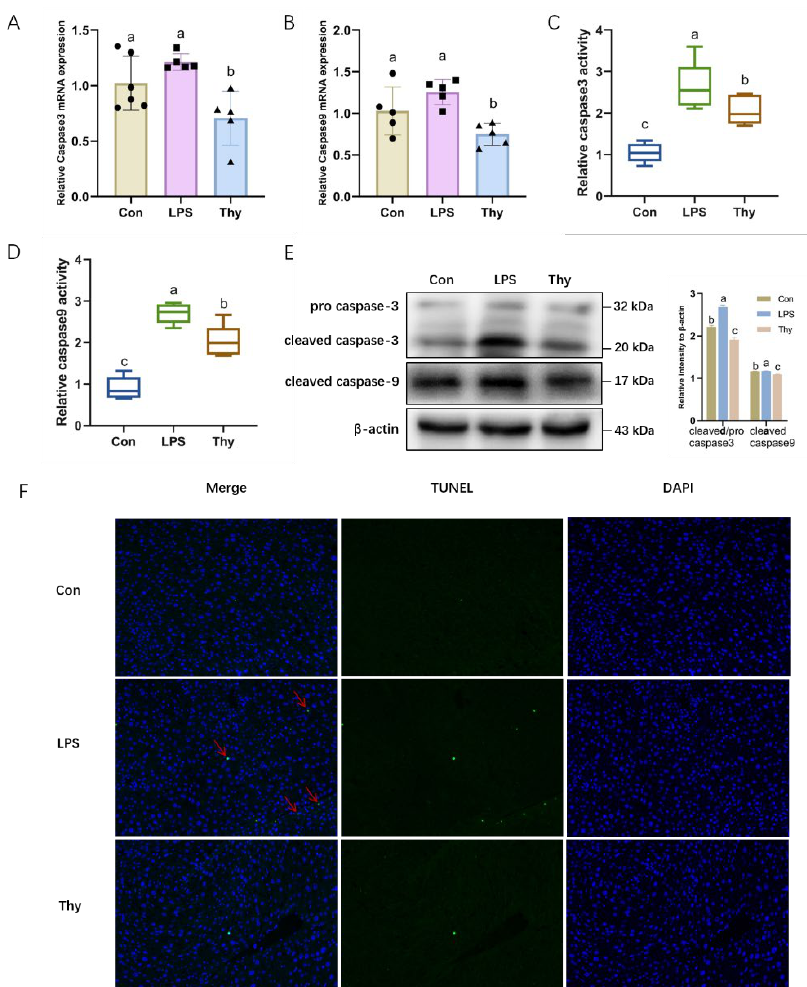
Figure 4. Thymol ameliorates LPS-induced apoptosis. The mRNA levels of apoptosis-related genes ( A ) caspase3 and ( B ) caspase9 in liver ( n = 5–6). The activity of ( C ) caspase3 and ( D ) caspase9 in liver ( n = 5–6); ( E ) The expression and quantification of pro caspase3, cleaved caspase3, and cleaved caspase9 in liver, as determined by Western blotting. Values are normalized to β -actin levels and expressed as the mean ± SD ( n = 6); ( F ) TUNEL apoptosis analysis (200× magnification). Con, control; Thy, thymol. Differences were presented with different superscript letters ( p < 0.05).